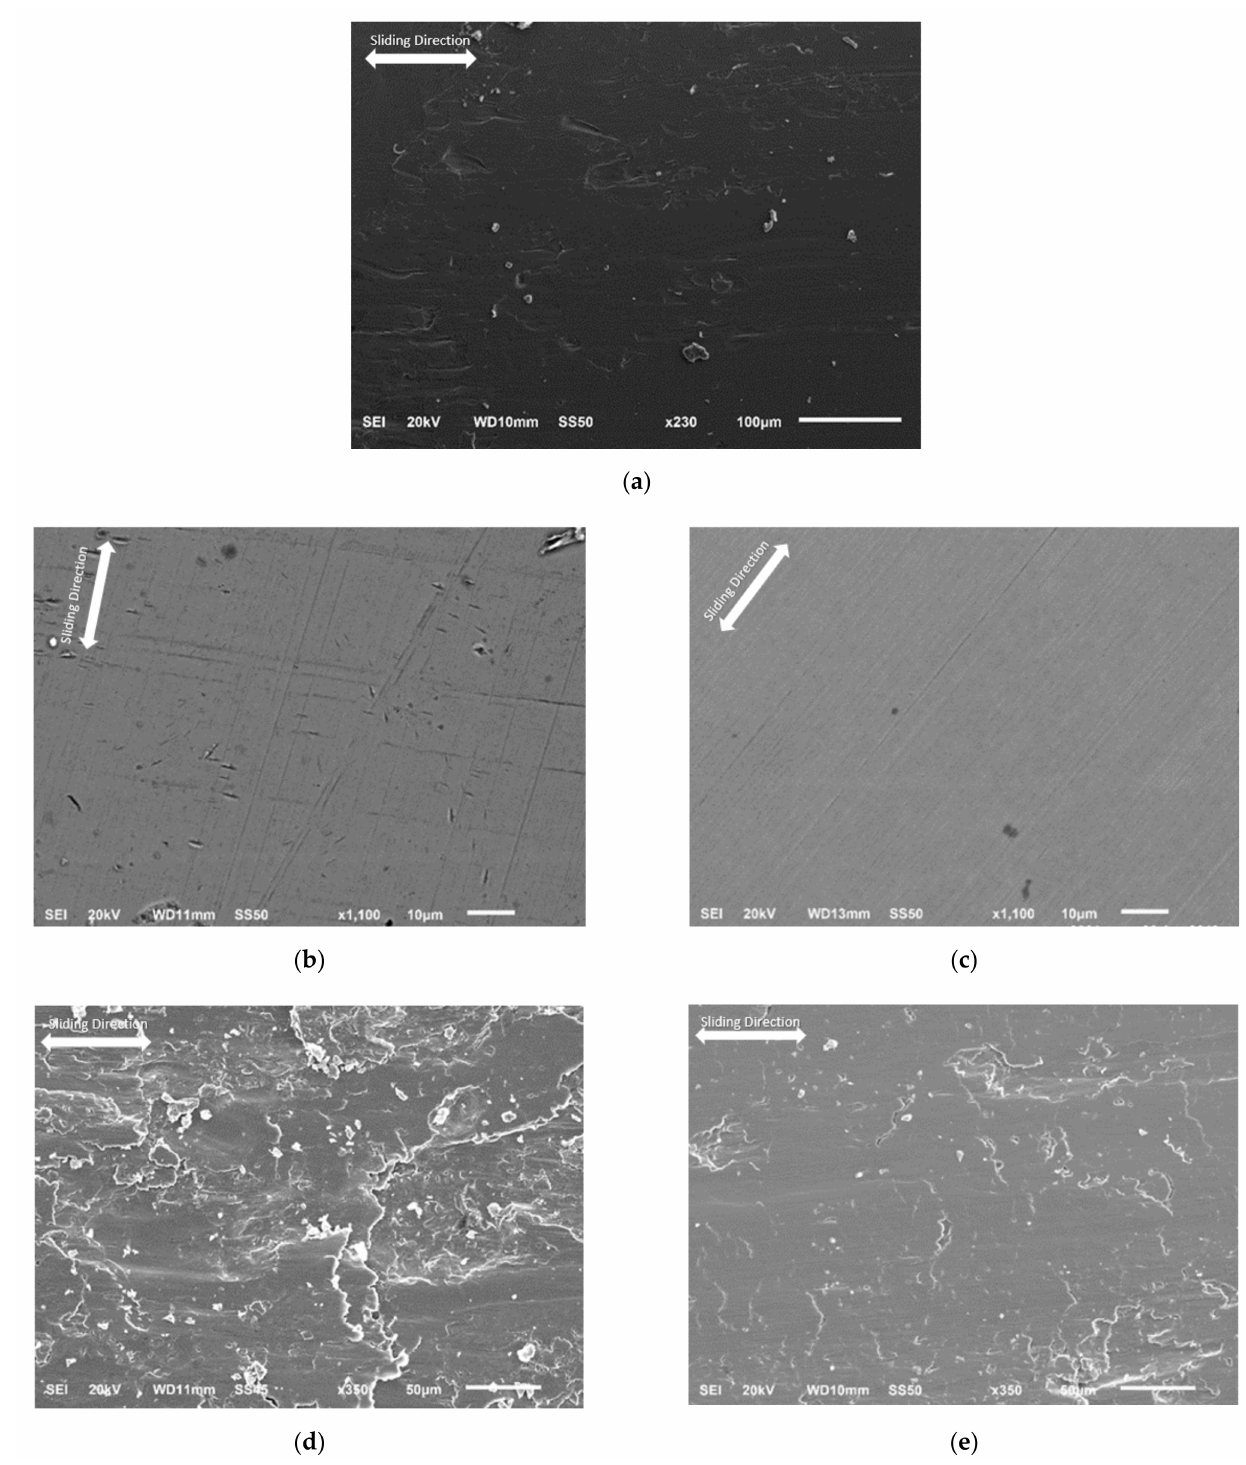
Figure 9. SEM observations on the: ( a ) as-received disks, ( b ) 288 ◦ C austempered disks, ( c ) 380 ◦ C quenched-tempered disks, ( d ) 343 ◦ C austempered disks, and ( e ) 585 ◦ C quenched-tempered